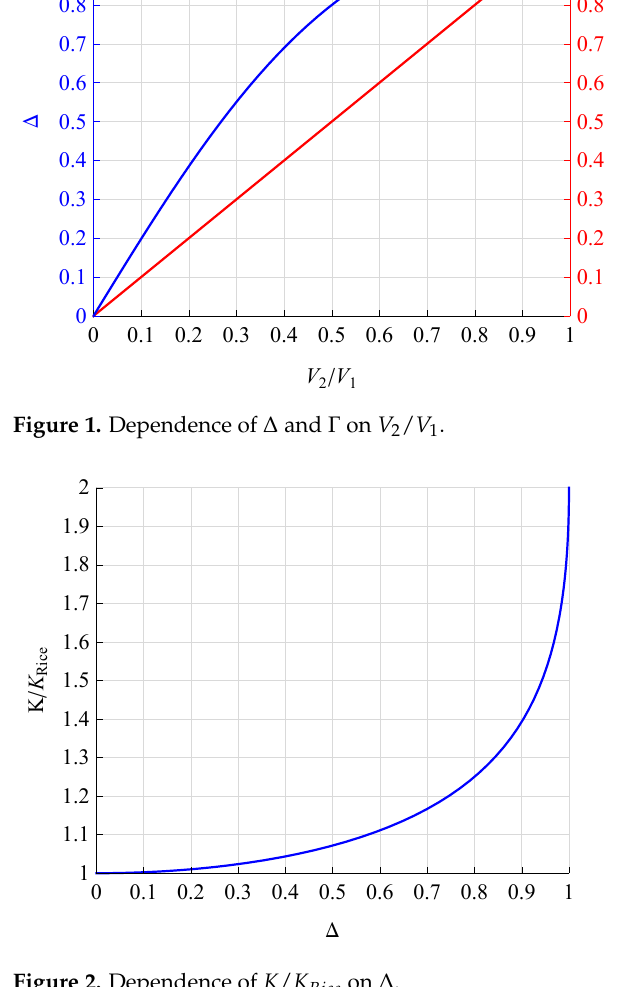
Figure 2. Dependence of K / K Rice on ∆ .